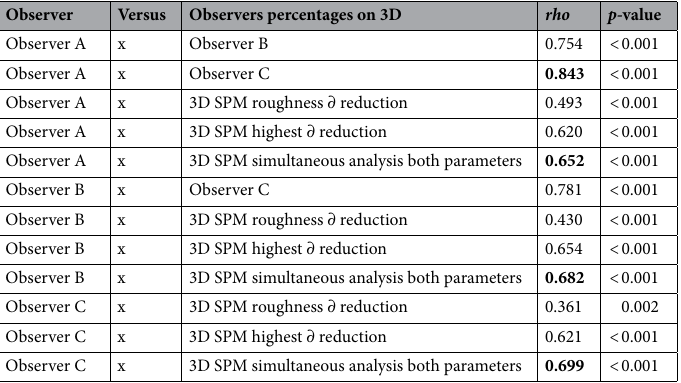
Table 5. Spearman’s rho correlation coefficient and the descriptive level ( p -value) of skin modification based on the percentages provided by the observers and 3D SPM ( n = 48